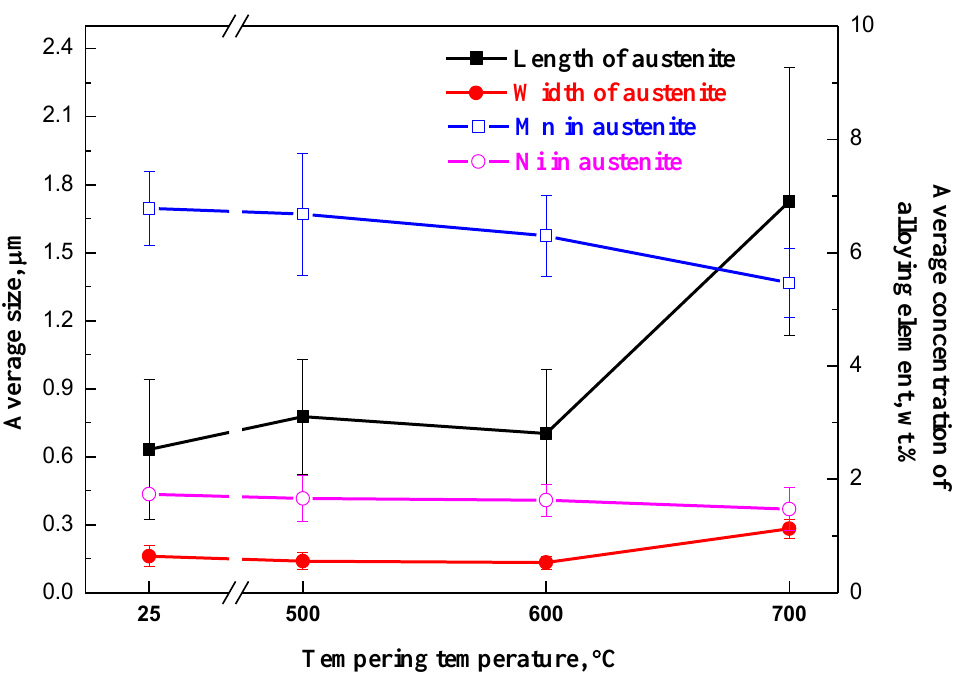
Figure 6. Statistic results of dimension (solid symbol) and alloying elements (Mn and Ni) concentration (blank symbol) of retained austenite by TEM images for samples before and after tempering at 500–700 °C.